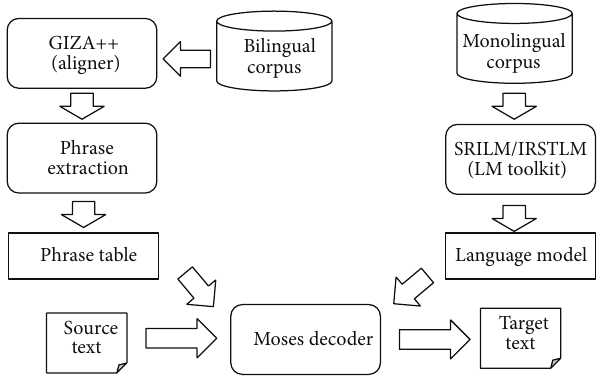
Figure 6: Moses’ main modules and models.